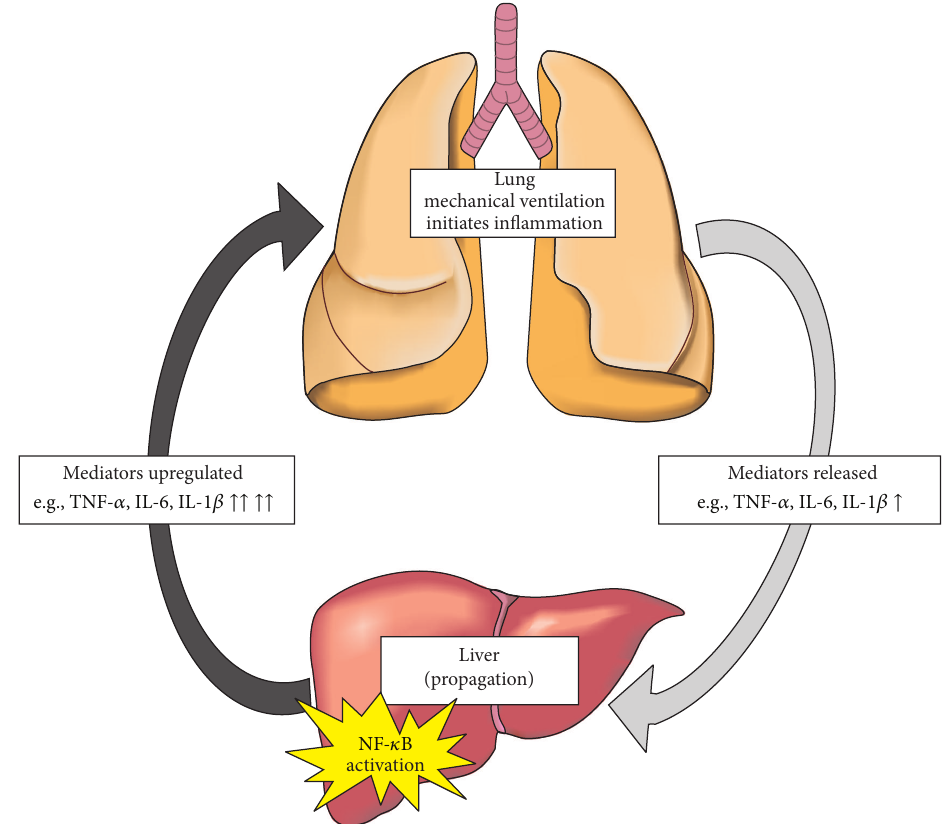
Figure 7: Proposed inflammatory pathway diagram. Inflammation initiated in the lung releases inflammatory mediators (light grey arrow, right side) which then translocate to peripheral organs (e.g., liver). These organs amplify the inflammatory signal, through an NF- 𝜅 B- dependent pathway, leading to further release of inflammatory mediators, which then travel back to the lung, and/or other peripheral organs (dark grey arrow) where the signal is further propagated in a feed-forward mechanism of acute